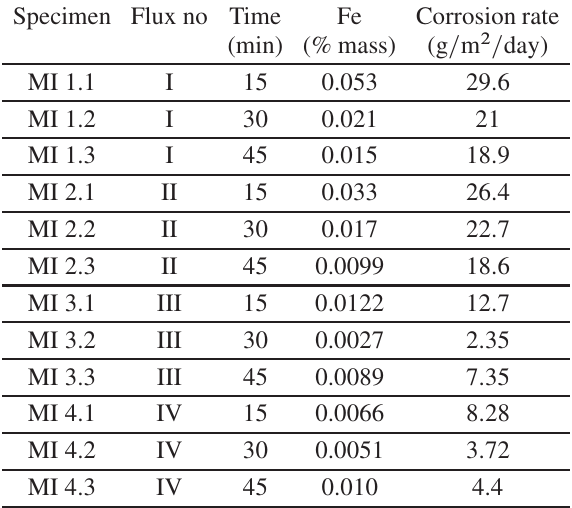
Table 6. Chemical analysis and corrosion rate results of refined magnesium.